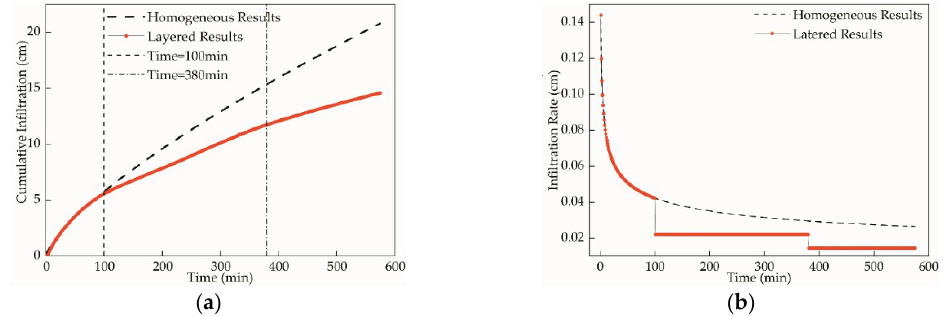
Figure 9. The variance of the cumulative infiltration and infiltration rate: ( a ) the relationship between the cumulative infiltration and time; ( b ) the relationship between the infiltration rate and time.